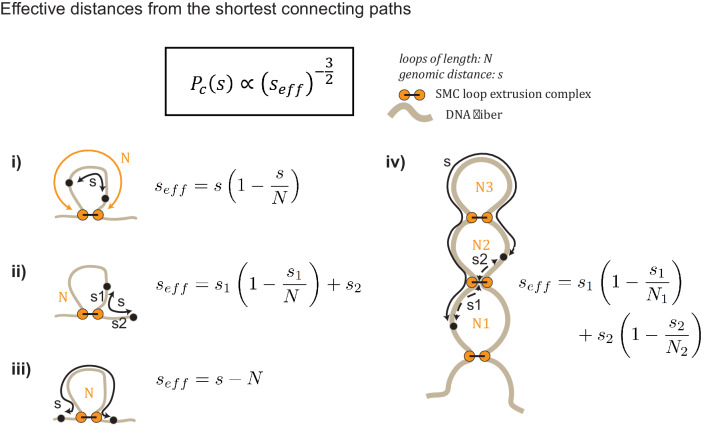
Generating Gaussian chain contact maps analytically from loop configurations.The contact probability Pc(s) is calculated by converting the true genomic distance, s, to its effective genomic distance seff. For example, in (i), the effective genomic distance is simply harmonic mean distance between the two paths in a loop (i.e., seff=(1/s+1/(N–s))−1 = s(1 - s/N)). Diagrams (i)-(iv) schematically illustrate the types of transformations used to calculate contact probability given a loop diagram.